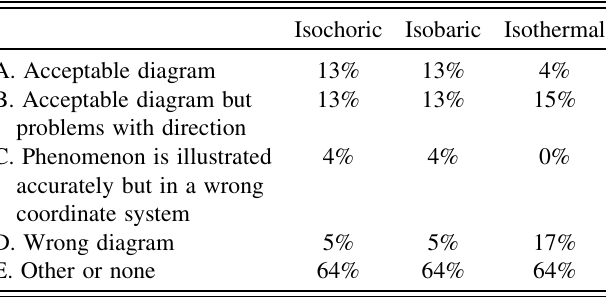
TABLE VI. Categorization of students’ pV diagrams con- cerned with three heat-absorbing thermal processes. N ¼ 75 .